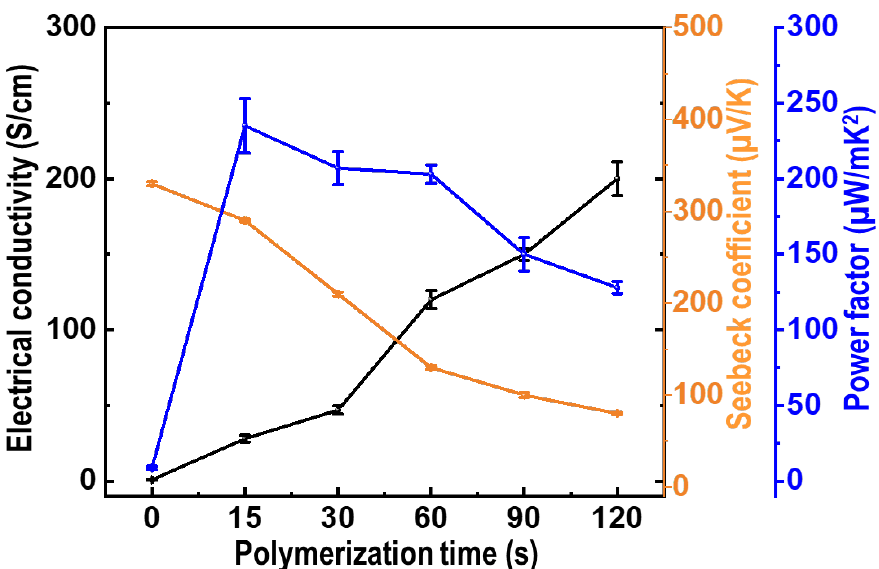
Figure 8. Electrical conductivity (black line), Seebeck coefficient (orange line), and power factor (blue line) of PEDOT/Te composite films as a function of PEDOT polymerization time at room tem- perature.